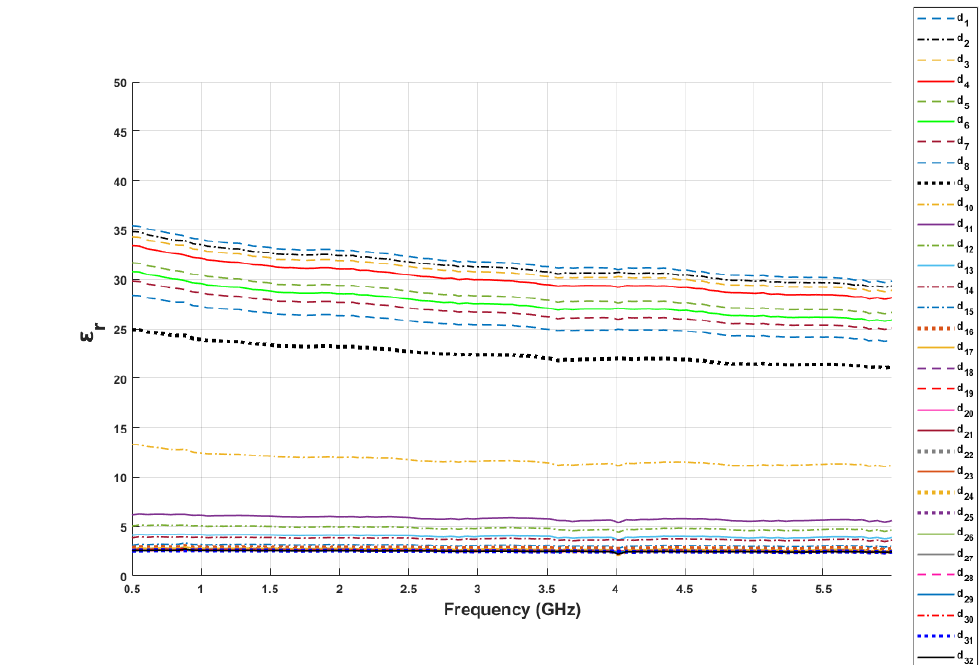
Figure 11. Relative permittivity of skin–olive oil as a function of frequency at various distances between the probe tip and first layer. The distances are expressed as d 1 to d 32 . In d 1 position indicates that the skin phantom layer was in full contact with the probe